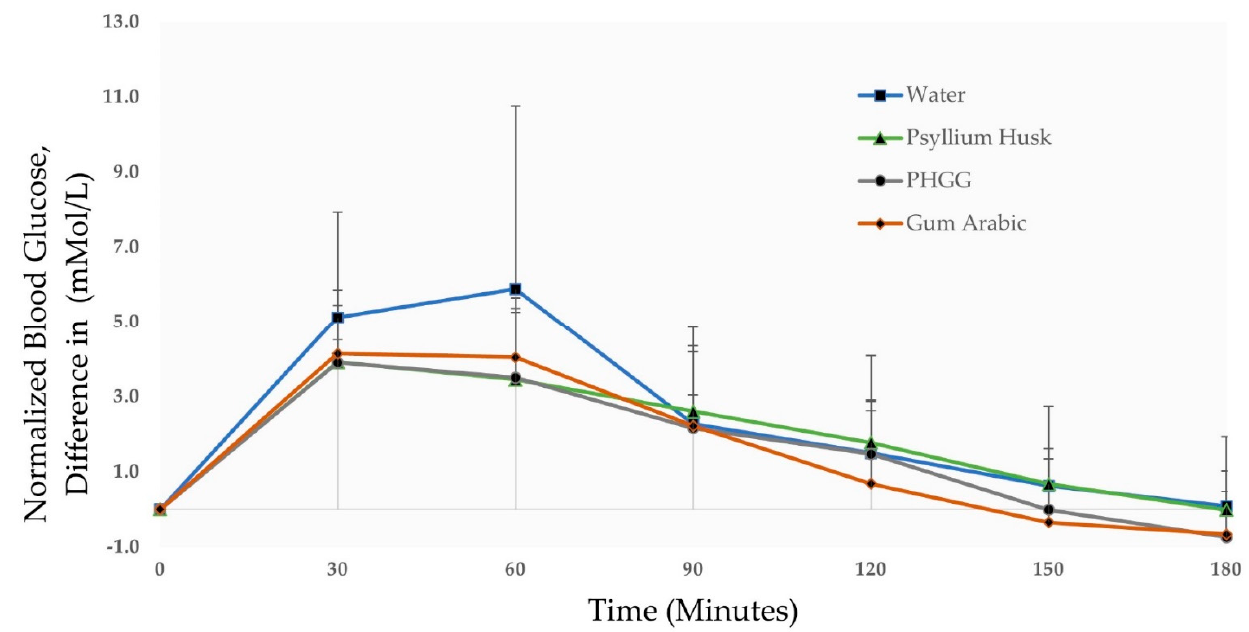
Figure 2. Changes in blood glucose concentration of participants ( n = 10) given test meals of water (negative control), psyllium husk (positive control), PHGG (test fibre 1), and gum Arabic (test fibre 2).